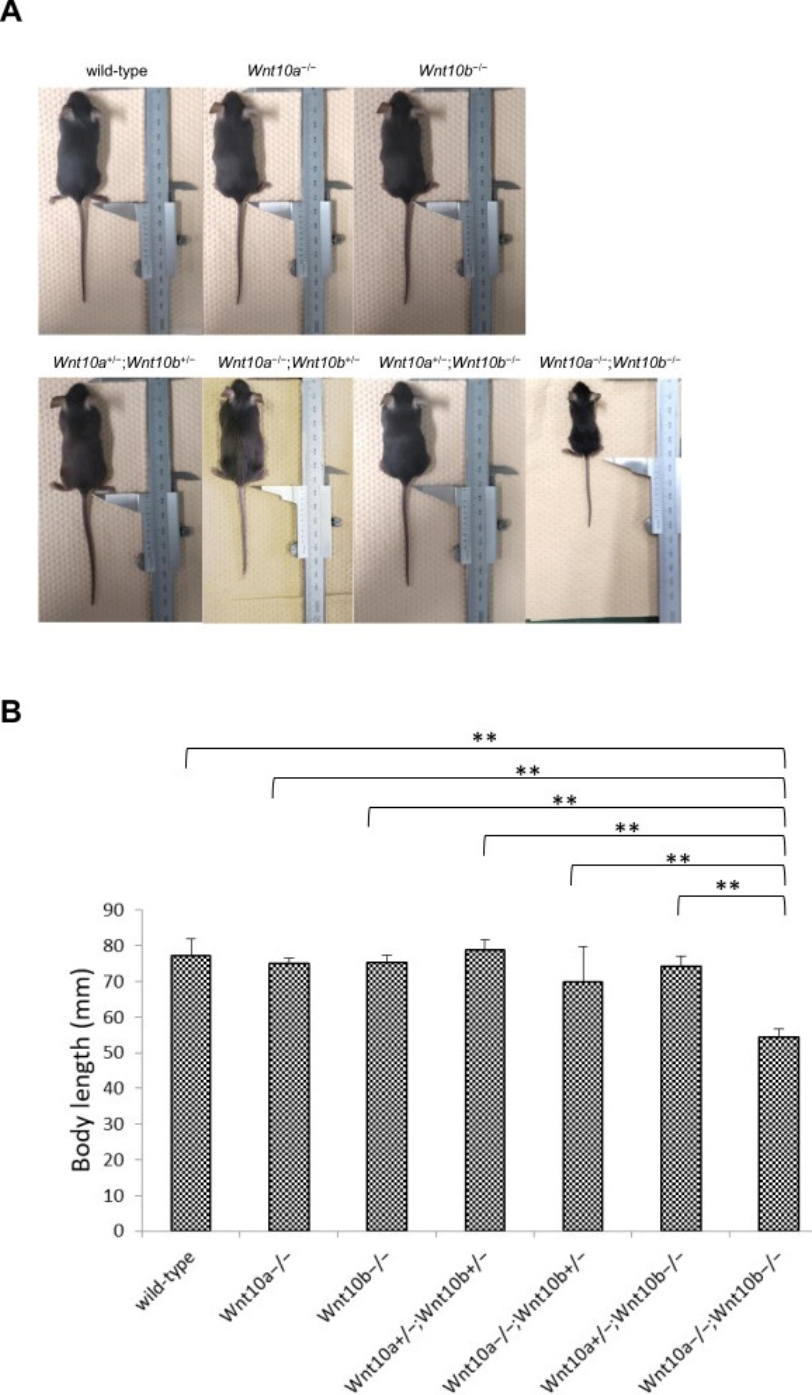
Figure 4. Wnt10a and Wnt10b double mutant mice have different growth rates. ( A ) Gross phenotype of 4-week-old wild-type and mutant mice. ( B ) In mutant mice, only Wnt10a − / − ; Wnt10b − / − mice showed a lesser growth rate than that of wild-type mice at 4 weeks. ** means p < 0.01.